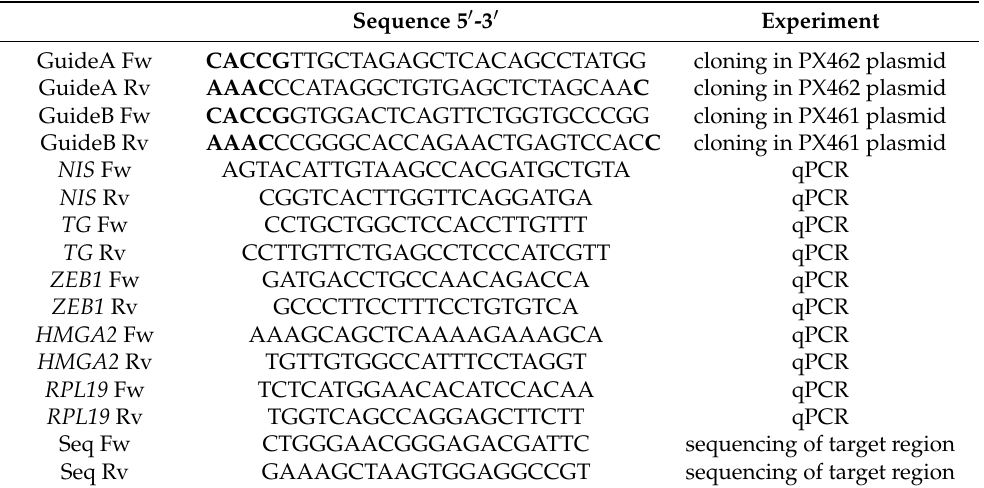
Table 1. Oligonucleotides